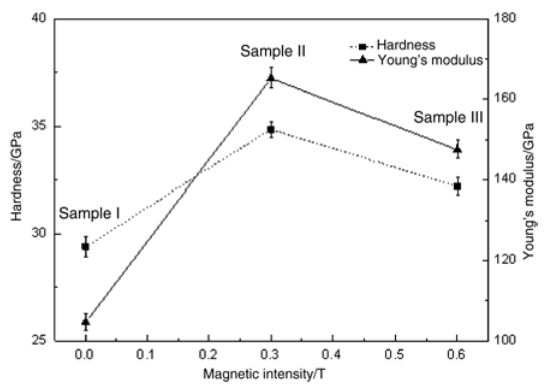
Figure 6: The hardness and Young’s modulus of Ni-TiN composite coatings as a function of magnetic intensity.